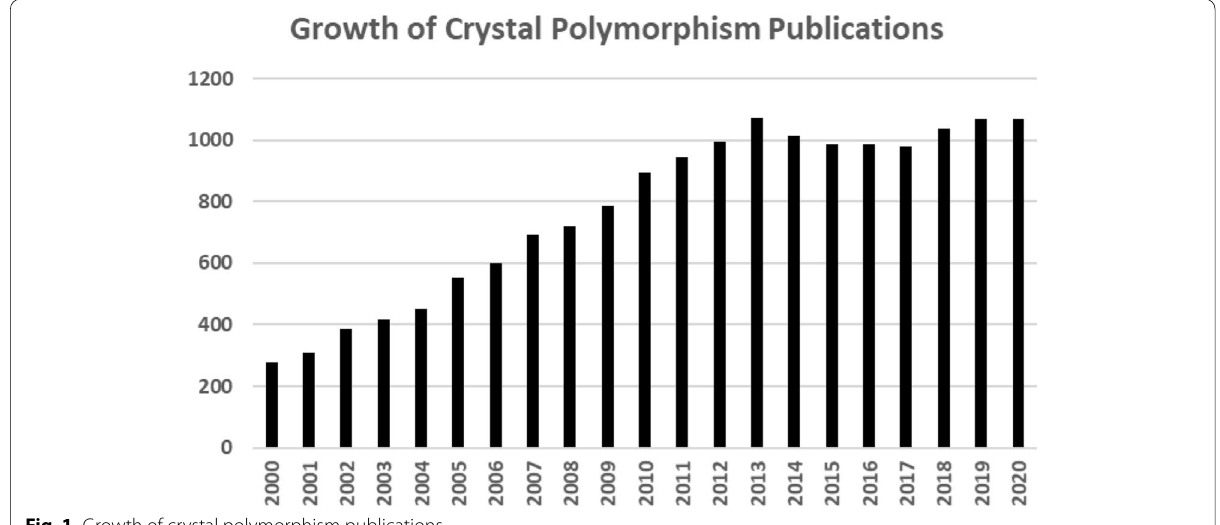
Fig. 1 Growth of crystal polymorphism